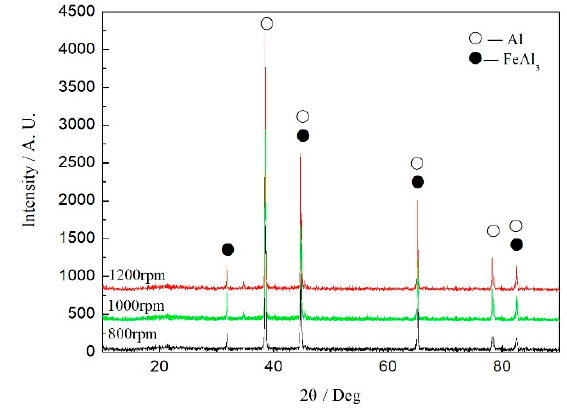
/ steel keyhole-free FSSW